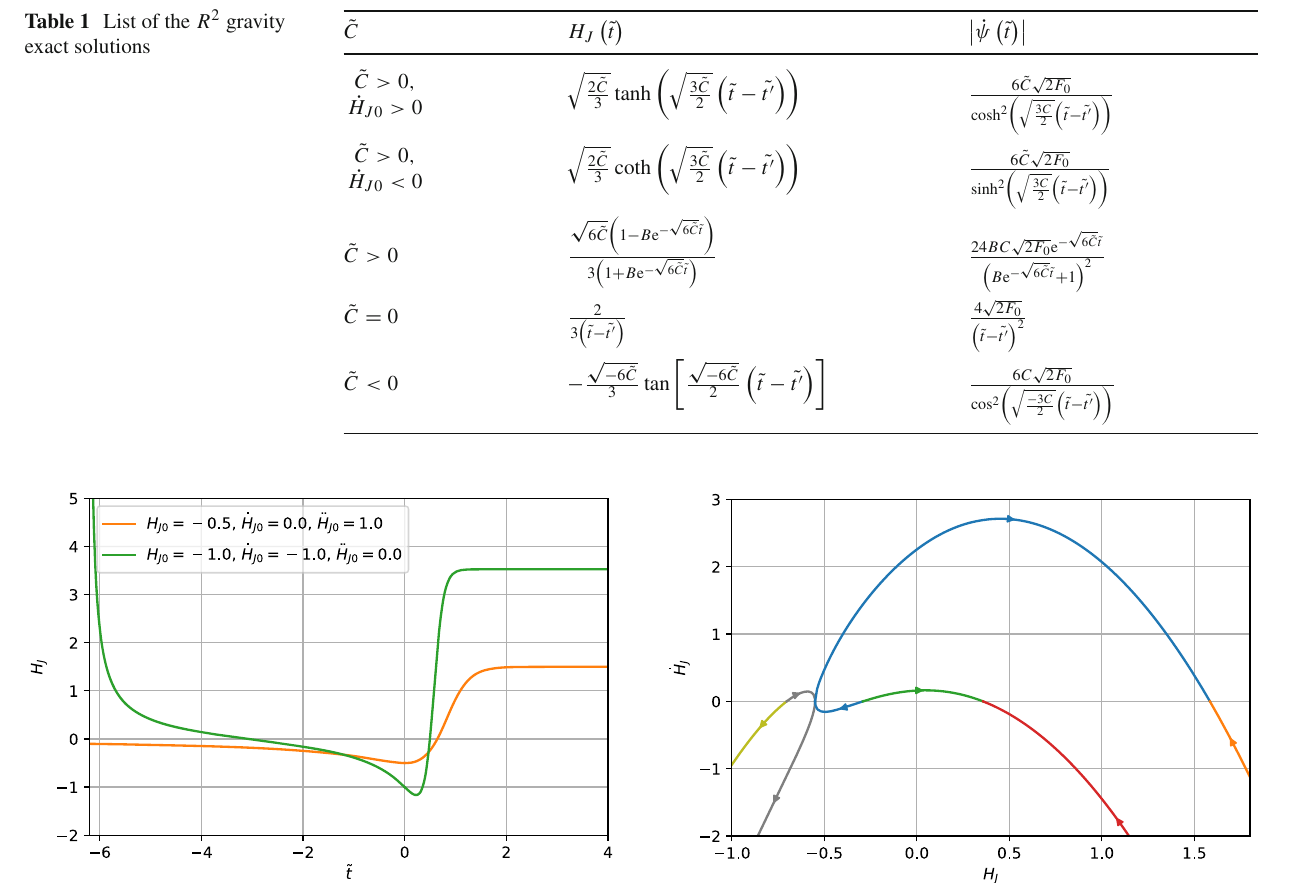
Fig. 1 The Hubble parameter H J ( ˜ t ) in the R 2 model considered